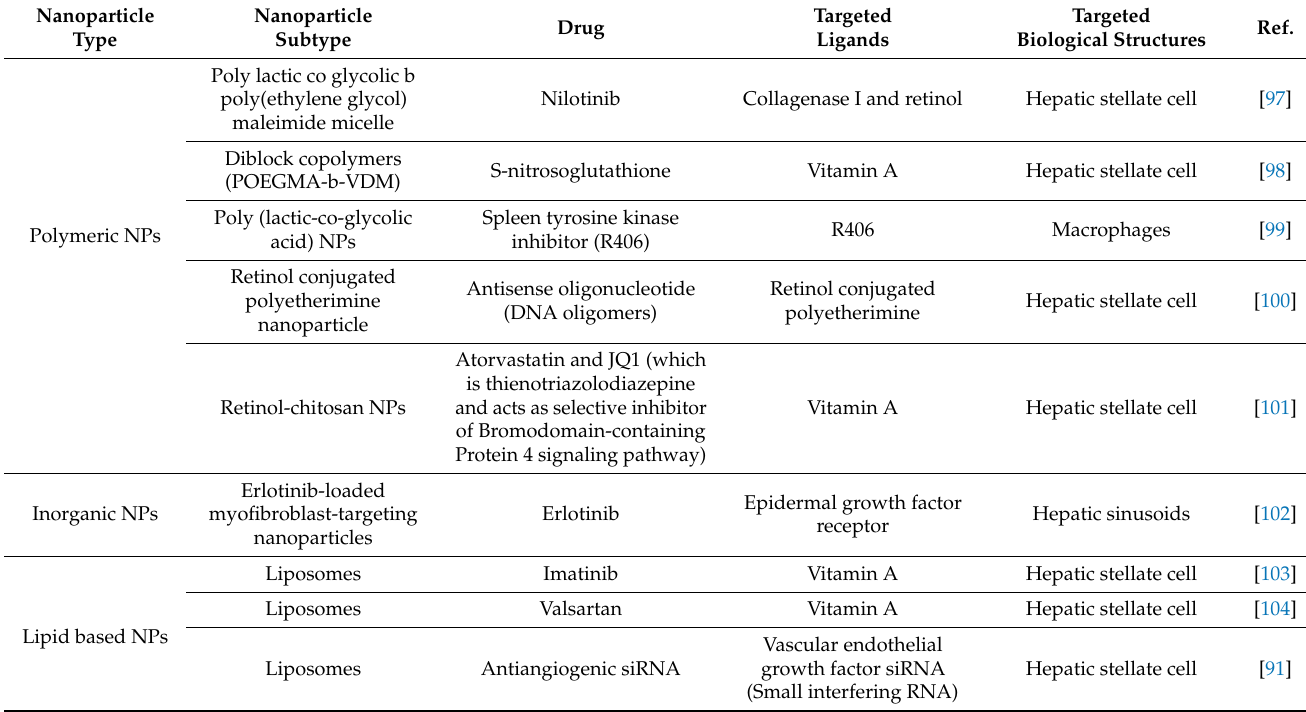
Table 1. Exploration of nanoparticles in targeted drug delivery of synthetic molecules for management of liver